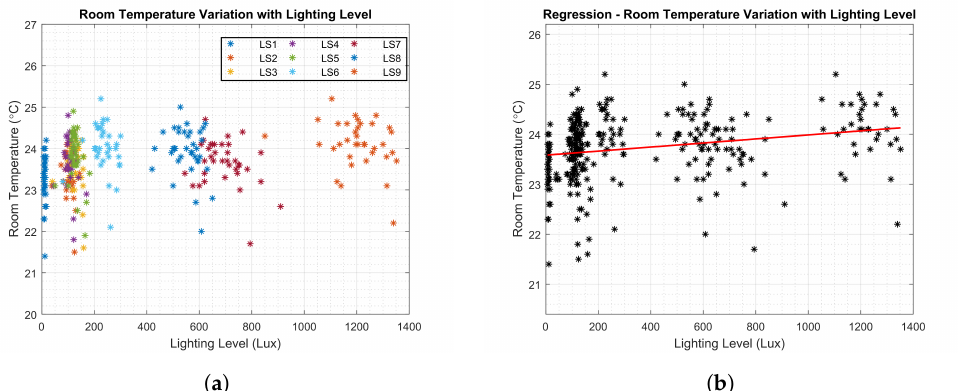
Figure 14. Room temperature change during the varying light level experiment. ( a ) Scatter plot, ( b )